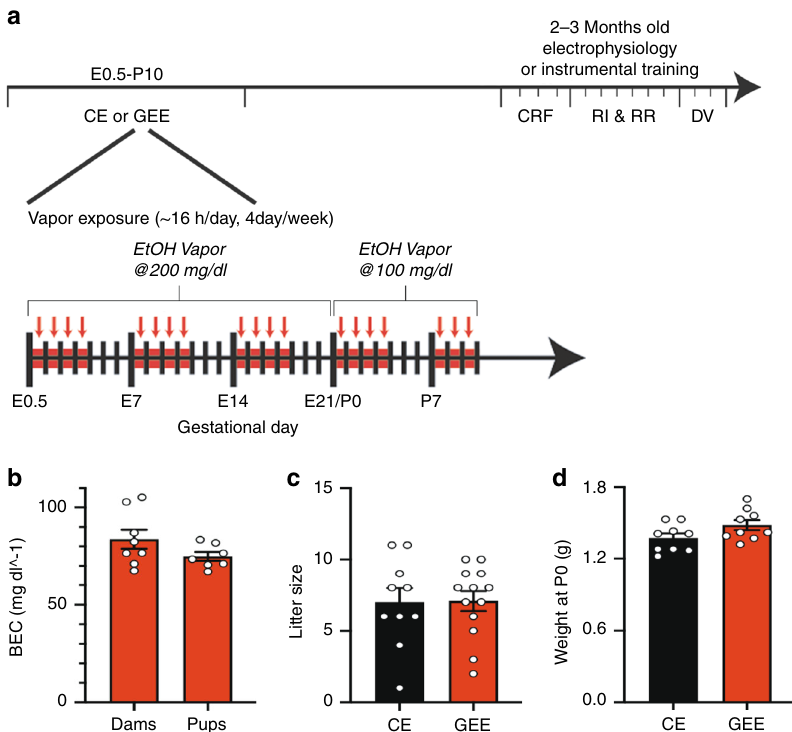
Fig. 1 Gestational ethanol exposure (GEE) paradigm. a Schematic diagram of the GEE paradigm. Mice were exposed to ethanol or air (CE) for 16 hours/ day for 4 days/week from embryonic day (E)0.5 to postnatal day (P)10. The ethanol vapor concentration averaged 200 mg/dl from E0.5-E21. After birth the ethanol concentration was lowered to average 100 mg/dl. At 2 – 3 months, mice were either used for ex vivo electrophysiology or instrumental training (continuous reinforcement schedules (CRF), training under random interval (RI) and random ratio (RR) schedules, and outcome devaluation (DV) tests). b GEE elicited similar blood ethanol concentrations (BEC) in dams (from E0.5-E21.5) and pups (from P0-P10). However, GEE did not alter ( c ) litter size or ( d ) body weight of offspring at birth. Black bars = CE mice; red bars = GEE mice. Error bars equal ±